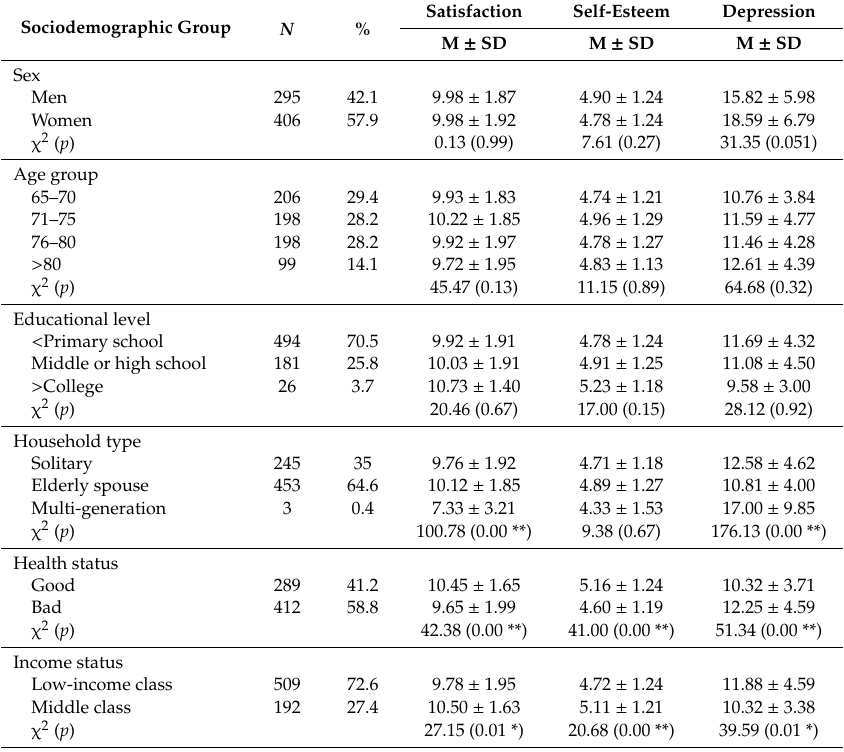
Table 2. Sociodemographic di ff erences in social capital satisfaction, self-esteem, and depression (N = 701).